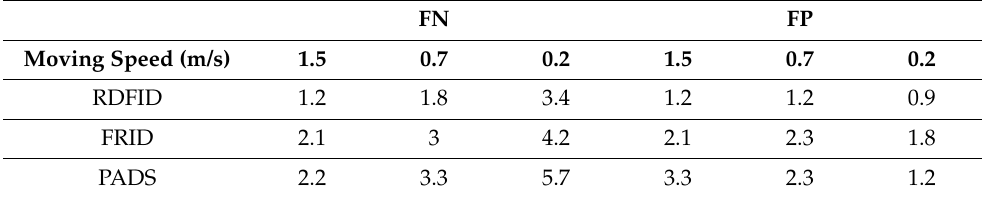
Table 6. FN/FP of human detection under different moving speeds (%).